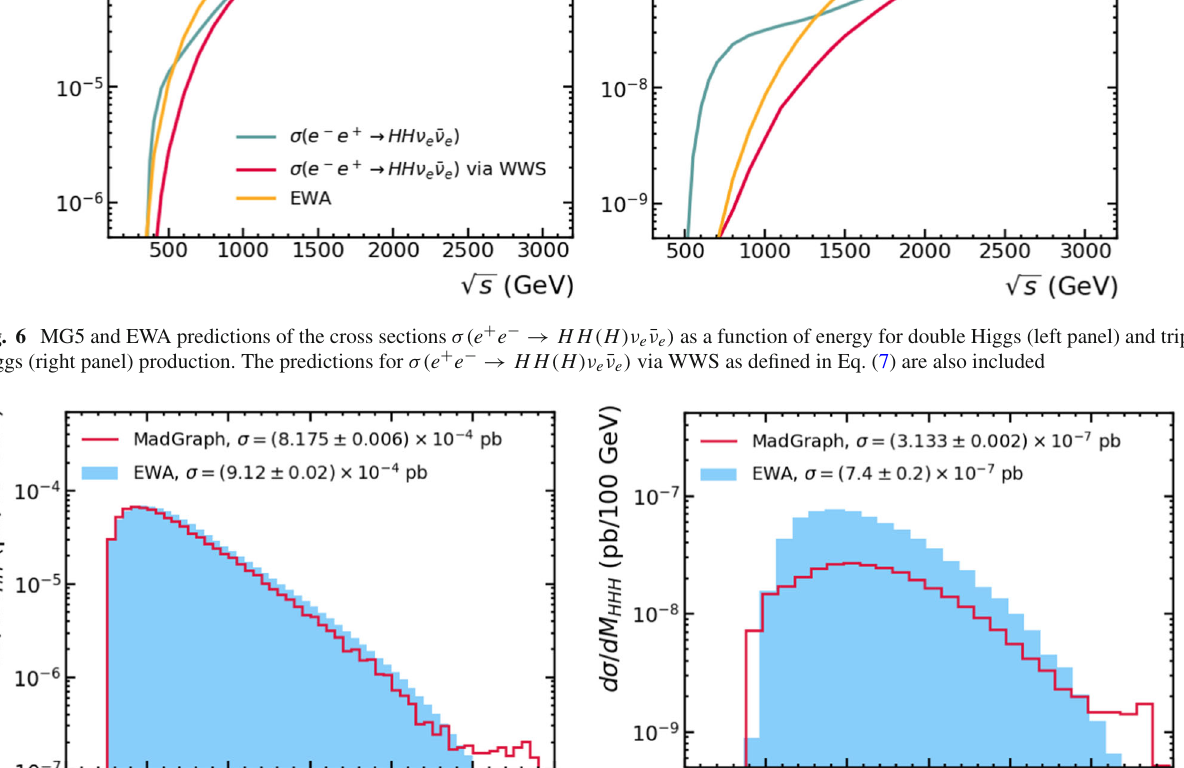
Fig. 7 Differential cross sections for e + e − → H H ν ¯ ν (left) and e + e − → H H H ν ¯ ν (right) at of the final Higgs bosons, M HH (left) and M HHH (right). The predictions from both MG5 and the EWA are included for